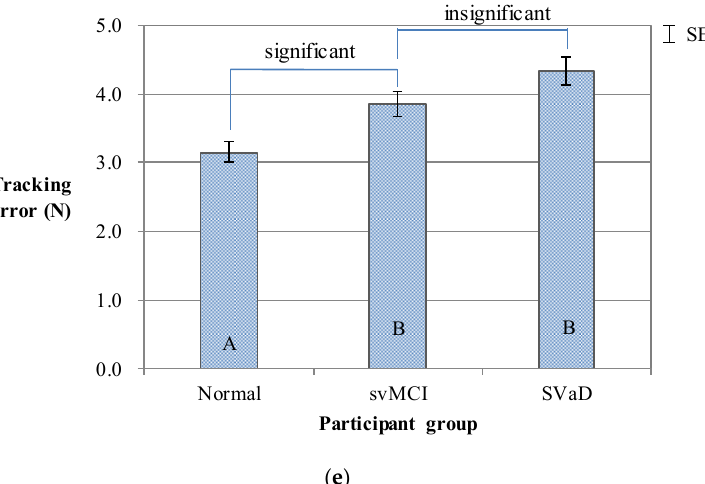
Figure 3. Force control capabilities of the normal, subcortical vascular mild cognitive impairment (svMCI), and subcortical vascular dementia (SVaD) groups (letters indicate statistical differences at α = 0.05). ( a ) Initiation time; ( b ) development time; ( c ) maintenance error; ( d ) termination time; ( e ) tracking error.